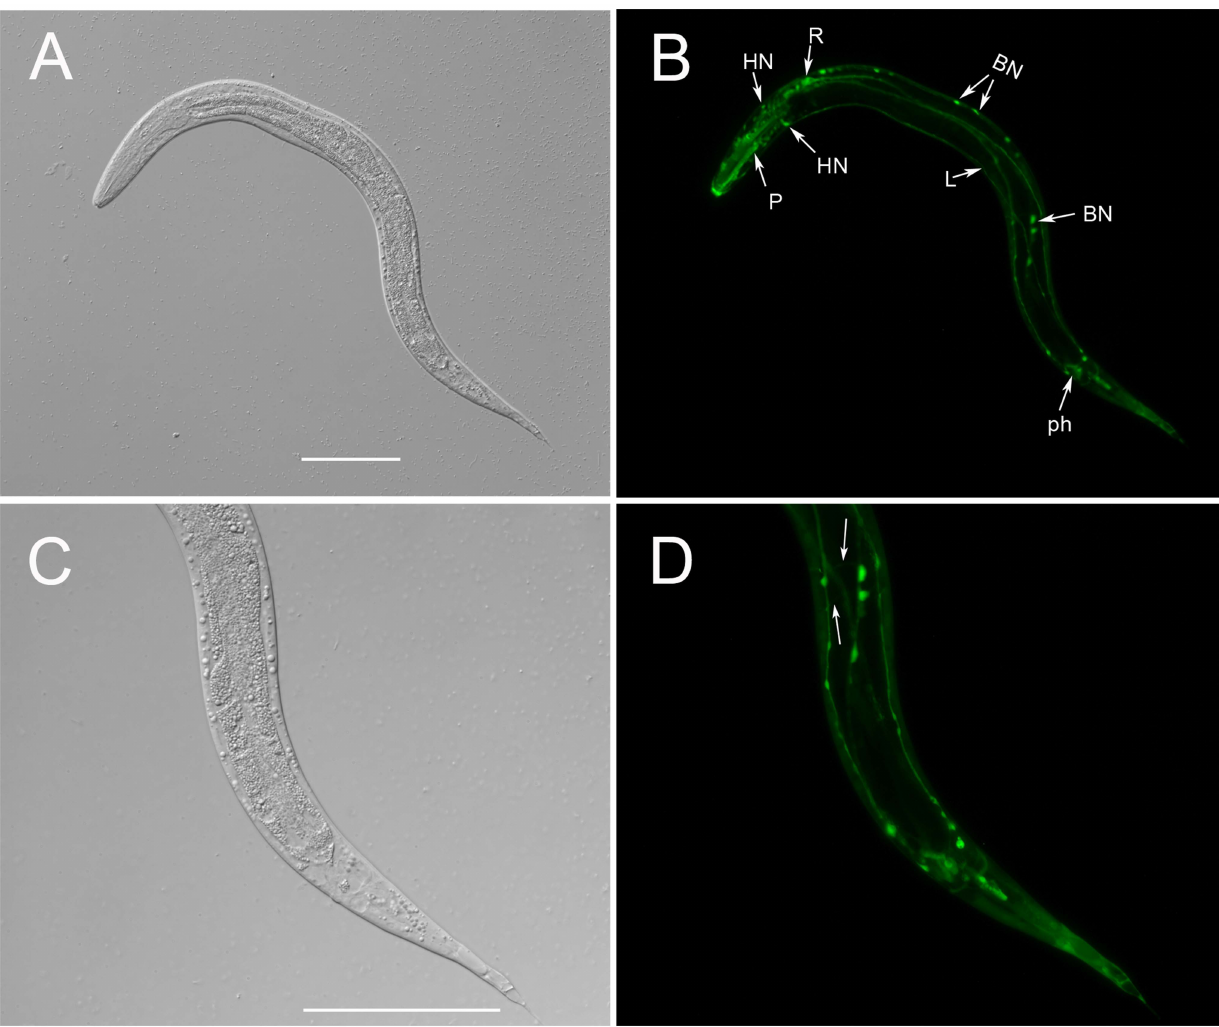
Figure 7. The spatial expression pattern of Ss-riok-1 in the post-free-living first-stage and second-stage larvae. DIC (A, C) and fluorescence (B, D) images of transgenic S. stercoralis post-free-living L1-L2 stage larvae expressing Ss-riok-1p::gfp::Ss-era-1t . (A, B) GFP expression in the pharynx (P), head neurons (HN), body neurons (BN) and tail phasmidial neurons (ph) and longitudinal nerve tracts (L), GFP expression is also observed in the neurons (R) with positional homology to neurons of C. elegans in retrovesicular ganglion (RVG). (C, D) GFP expression in the commissures between body neurons and longitudinal nerve tracts (arrow). Scale bars=100 m m.